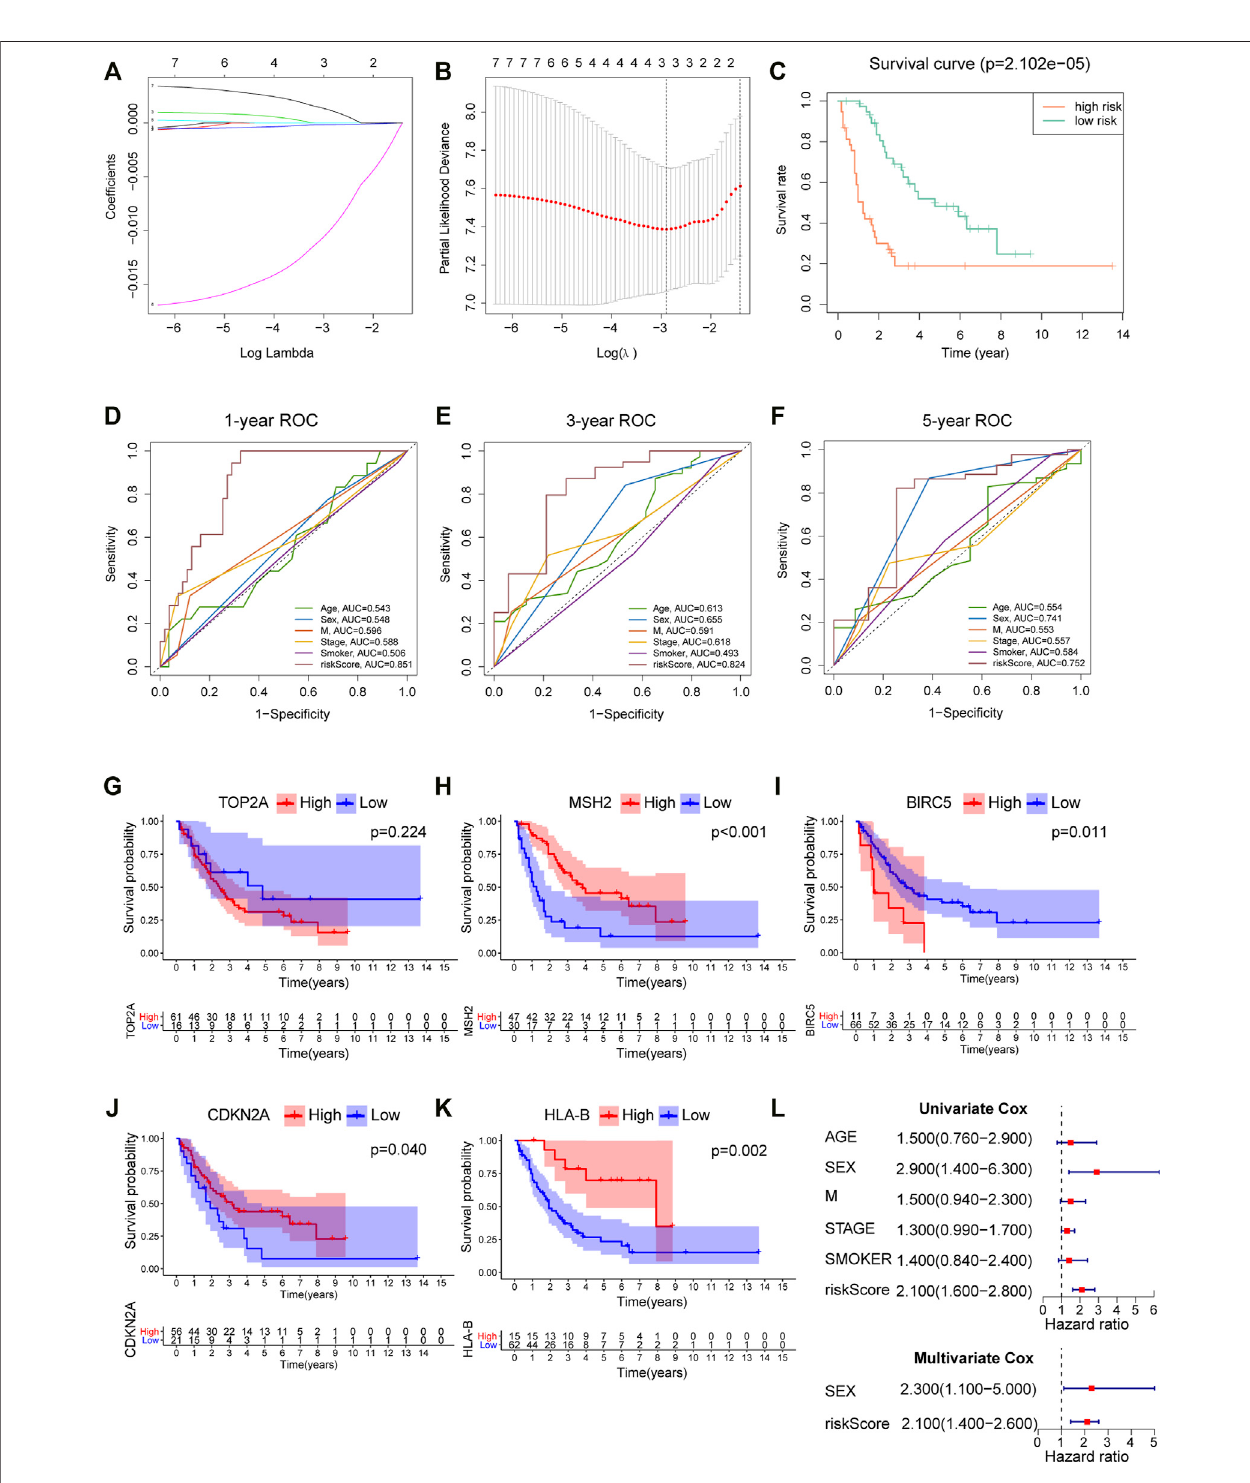
FIGURE 5 | Construction and veri fi cation of a prognostic model for SCLC. (A) Coef fi cient patterns of the candidate 7 variables in the LASSO model. (B) Tenfold crossvalidationwasappliedtoselecttheproximalturningparameter( λ ) via minimumcriteria(the1-SEcriteria)intheLASSOmodel. (C) Kaplan – Meiercurvesof77SCLC patientsstrati fi edbythemedianvalueofriskscore. (D – F) 1-,3-,and 5-yearROCcurves ofriskscore,age,sex,distantmetastasis, clinicalstage,and smoking history in thecBioPortalcohort. (G – K) Survivalanalysisofplatinumresistance – relatedgenesandHLA-Bin77SCLCpatients;themedianexpressionofeachgenewasused as the cutoff. (L) Forest maps of univariate and multivariate Cox regression in the cBioPortal cohort.